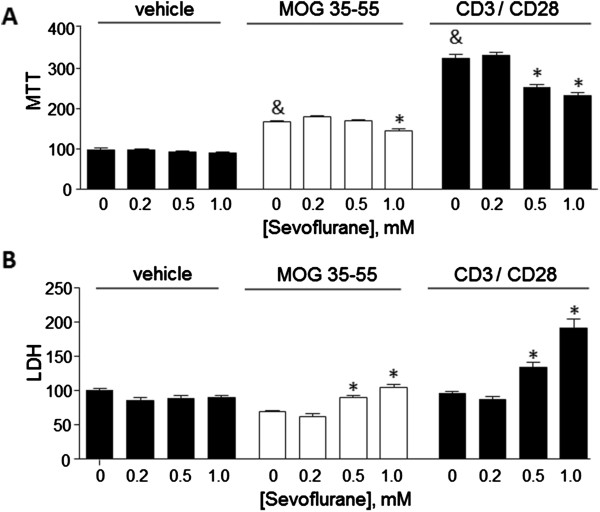
Sevoflurane reduces T cell proliferation and induces T cell death. Splenic T cells as described in Figure 5 were assayed after 24 h for (A) cell proliferation using the 3-(4,5-dimethylthiazol-2-yl)-2,5-diphenyltetrazolium bromide (MTT) assay; and (B) cell death by measurement of lactate dehydrogenase (LDH) in the culture media. The data are mean ± SEM of n = 4 samples per group, and are relative to values measured for vehicle-treated cells with 0 sevoflurane. &P <0.05 versus vehicle, 0 sevoflurane (t test); *P <0.05 versus 0 sevoflurane (one way analysis of variance (ANOVA), Tukey post hoc test).